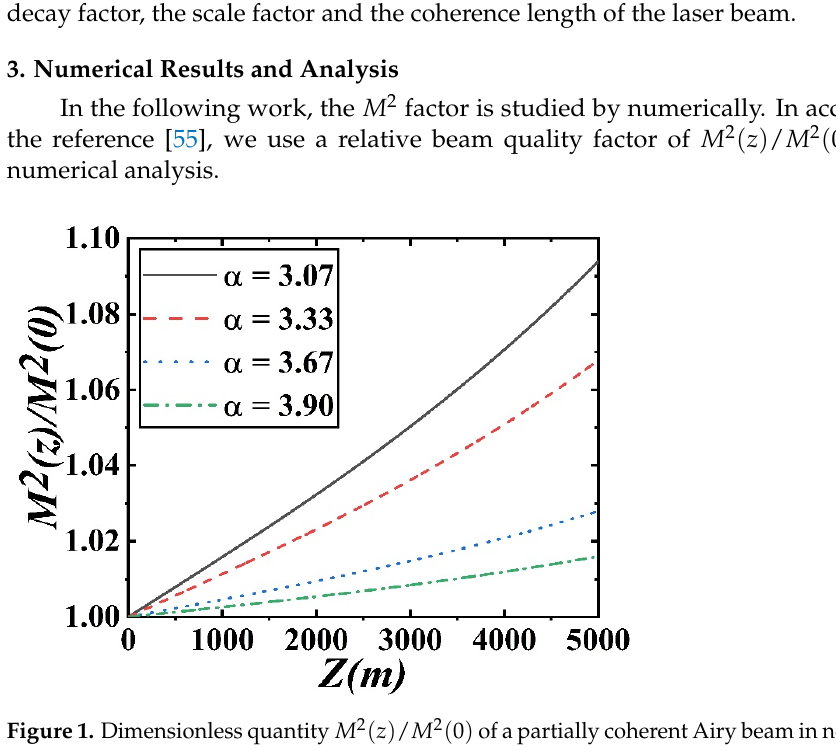
Figure 1. Dimensionless quantity M 2 ( z ) / M 2 ( 0 ) of a partially coherent Airy beam in non-Kolmogorov turbulence versus propagation distance for different α .